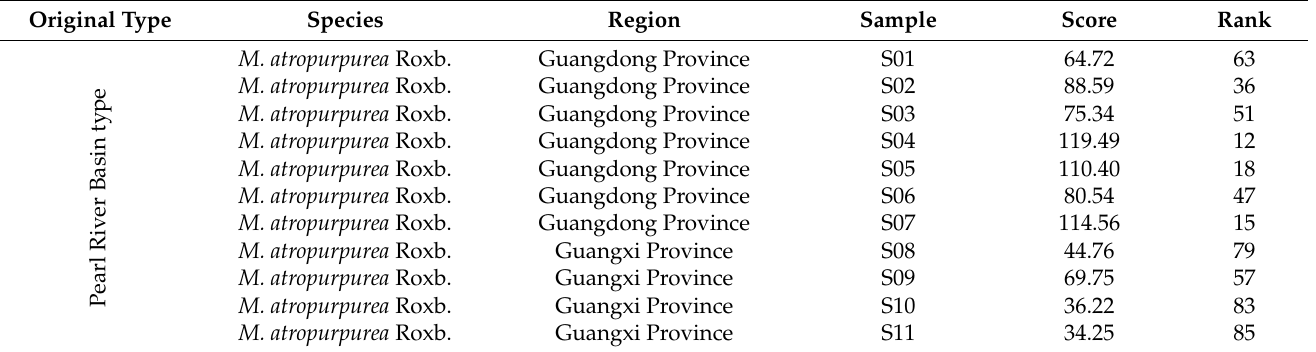
Table 3. Comprehensive evaluation of M. spp. leaves from different areas using the CRITIC